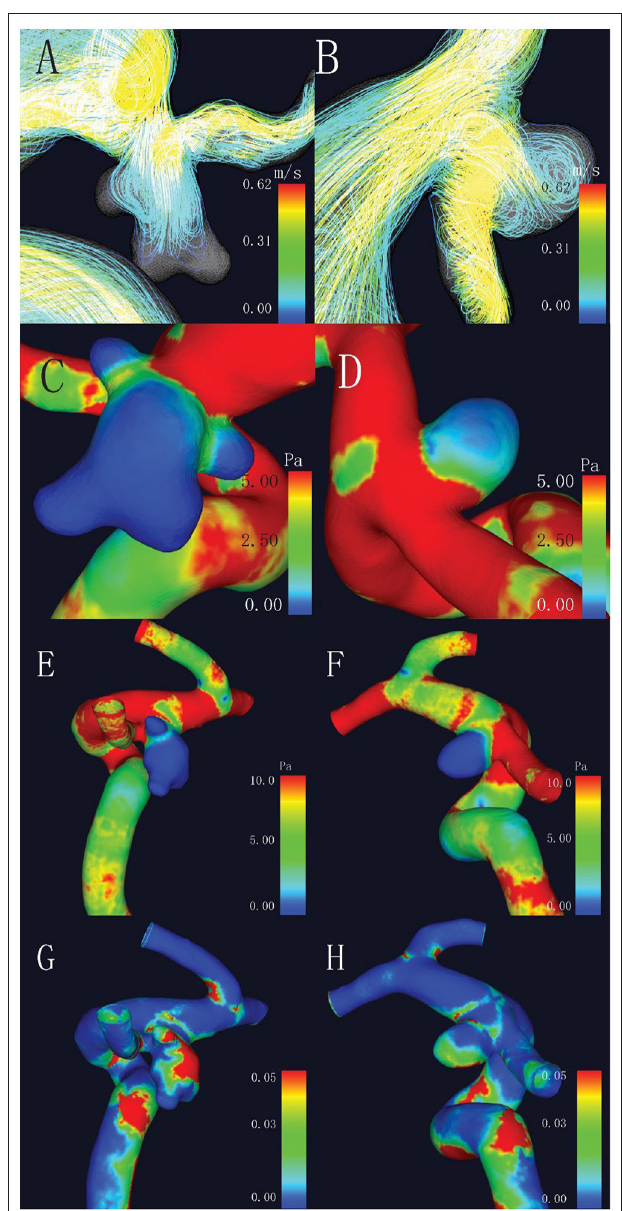
FIGURE 2 | Comparison of hemodynamic characteristics of mirror aneurysms in a typical patient. (A) Complex flow pattern in ruptured aneurysm with blebs; (B) Simple flow pattern in unruptured aneurysm; (C,D) Lower wall shear stress (WSS) was observed in the ruptured aneurysm (2.47 vs. 2.72Pa, p = 0.017); (E,F) No statistical differences in maximum WSS (MWSS) (44.45 vs. 14.56Pa, p = 0.509); and (G,H) Higher oscillatory shear index (OSI) in the ruptured aneurysm (0.031 vs. 0.025, p = 0.037).